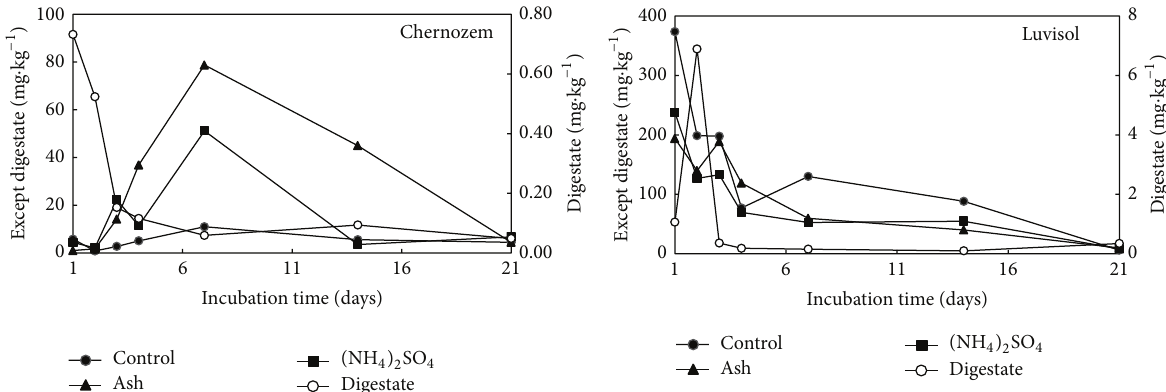
Figure 1: The concentrations of Hg extractable with 0.11molL −1 acetic acid within the incubation experiment (mg ⋅ kg −1 ) according to the individual